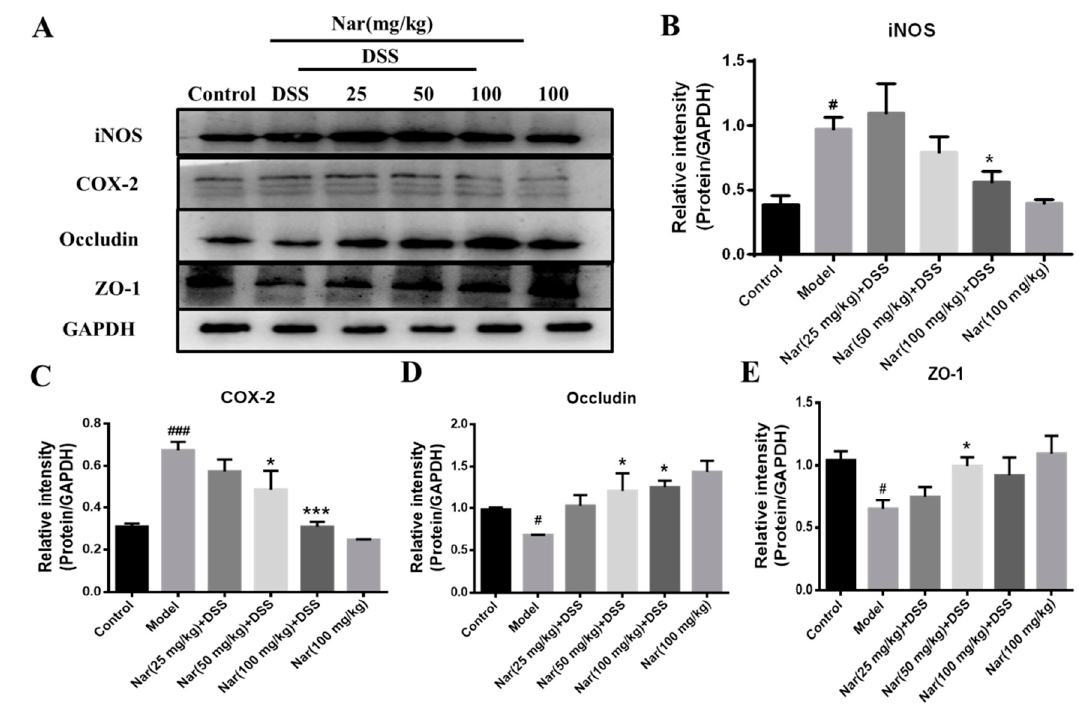
Figure 5. Expression of related proteins in tissues of ulcerative colitis mice. ( A ) The protein expressions of iNOS, COX-2, Occludin and ZO-1 were detected by Western blotting. GAPDH was used as an internal control. The gray density scanning analysis of iNOS ( B ), COX-2 ( C ) and occludin ( D ) and ZO-1 ( E ). Data are presented as means ± SD ( n = 3). # p < 0.05 and ### p < 0.001, compared with the control group; * p < 0.05 and *** p < 0.001, compared with the model group.